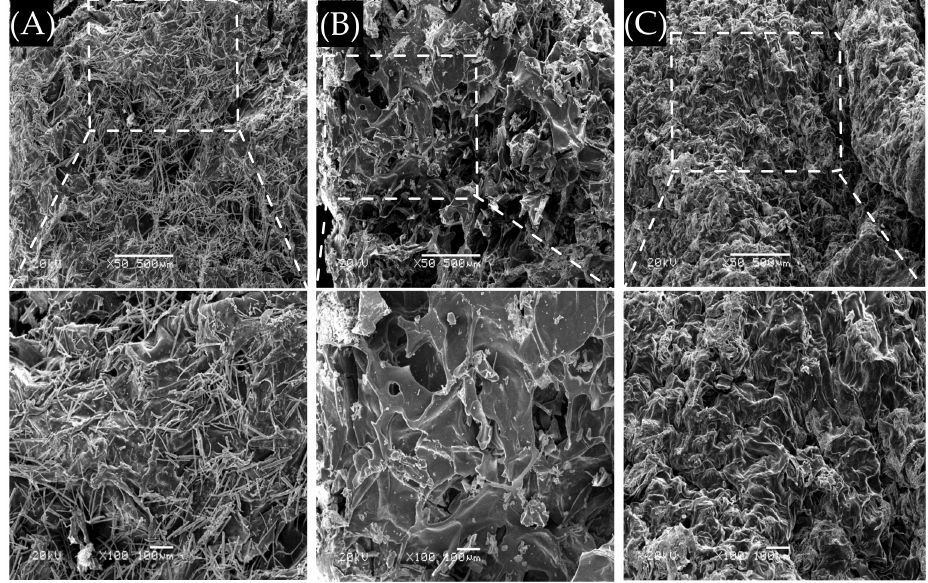
Figure 3. SEM images of the OPHs. ( A – C ) OPH-1, OPH-2, and OPH-3, respectively. They were magnified as multiples of 50 and 100, and the scales are 500 µ m and 100 µ m, respectively.